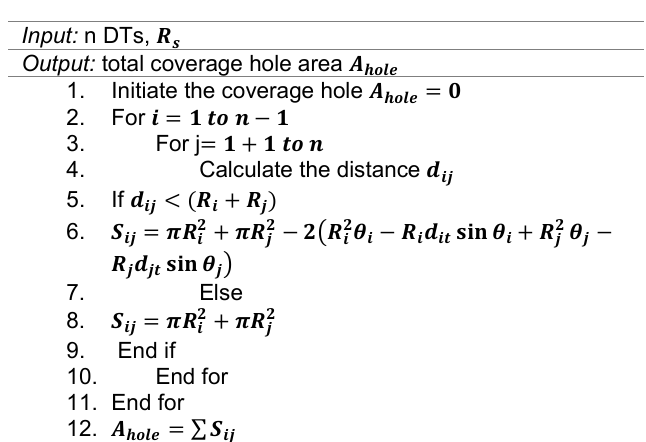
Table 1. Different behaviors of Logistic map for